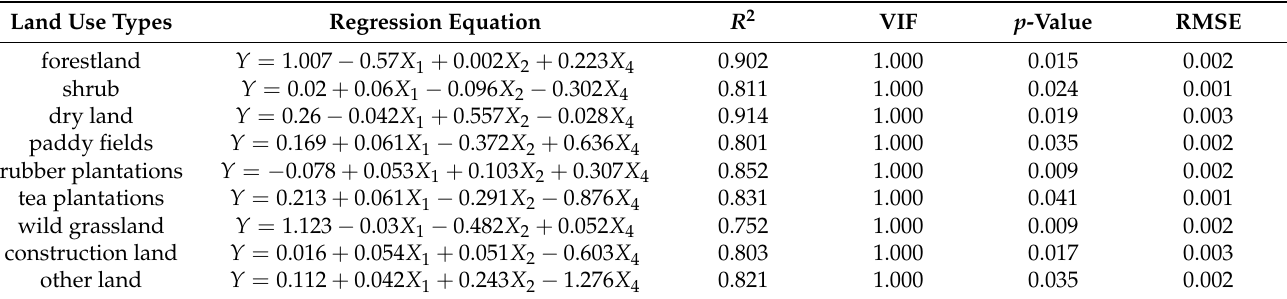
Table 5. Results of the stepwise linear regression analysis of factors driving land use change in Xishuangbanna and their residuals versus predicted